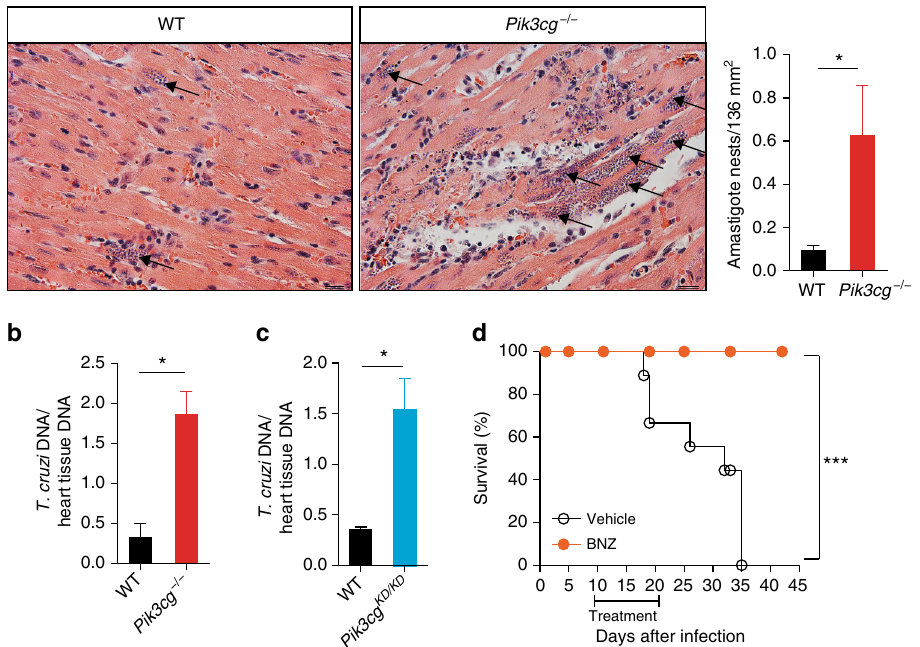
Fig. 6 PI3K γ controls the heart parasitism after infection with T . cruzi . a Representative images from H&E staining of heart tissue from WT ( n = 6) and Pik3cg − / − ( n = 6) mice 18 days post infection with T . cruzi Y strain. Black arrows indicate amastigote nests of the parasite. Scale bars = 20 µ m. b , c Quantitative PCR analysis of T . cruzi DNA isolated from Pik3cg − / − ( b ) and Pik3cg KD/KD ( c ) mice 18 days post infection with T . cruzi Y strain. d Survival rate of Pik3cg − / − mice infected with 10 3 trypomastigote forms of T . cruzi Y strain and treated with 100 mg Kg − of benznidazole (BNZ) ( n = 8) or vehicle ( n = 6). * P < 0.05, by unpaired Student ’ s t -test, relative to WT mice ( a – c ). * P < 0.05 and *** P < 0.001 (unpaired Student ’ s t -test in a – c and Mantel – Cox log-rank test in d ). Data are from one experiment ( d ) or representative of two ( c ) or three ( a , b ) independent experiments (mean ± s.e.m in a – c